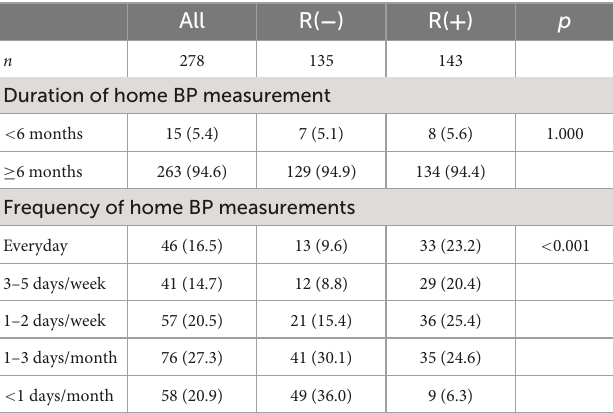
TABLE 1 Duration and frequency of home blood pressure measurements in patients who responded to measure home blood